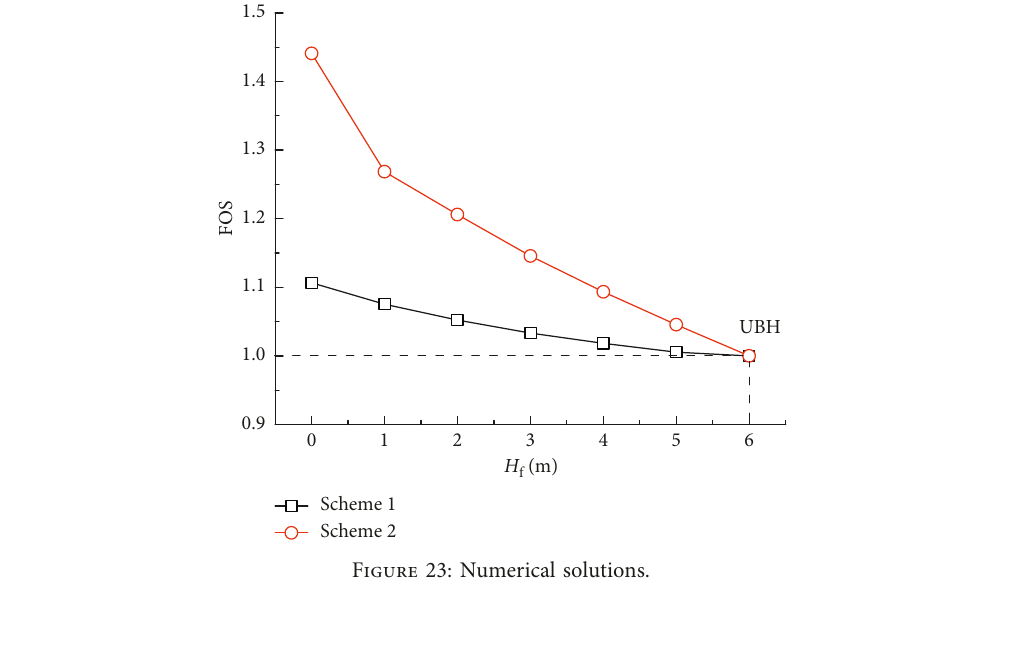
Table 4: Solutions of UBH.